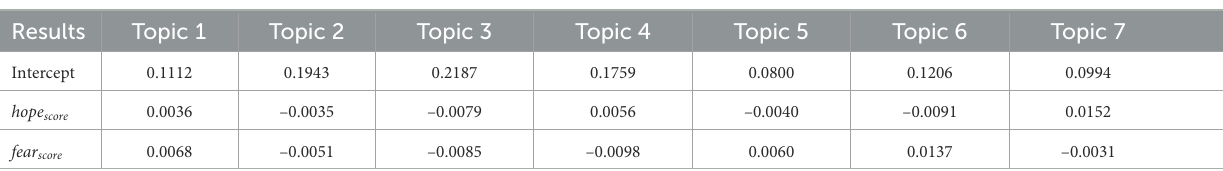
TABLE 2 Topic modeling analysis